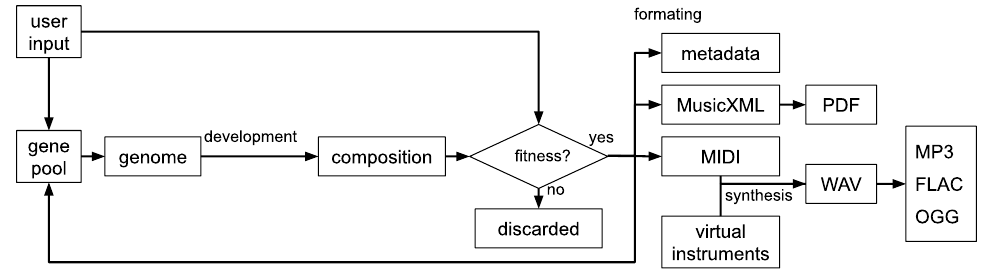
Figure 6. A graphical representation of the composition workflow.